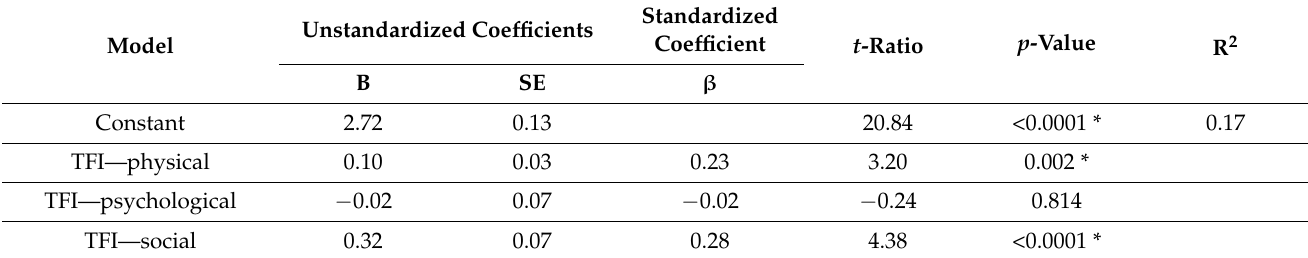
Table 6. Linear regression analysis with the “appointment-keeping” domain as the dependent variable.